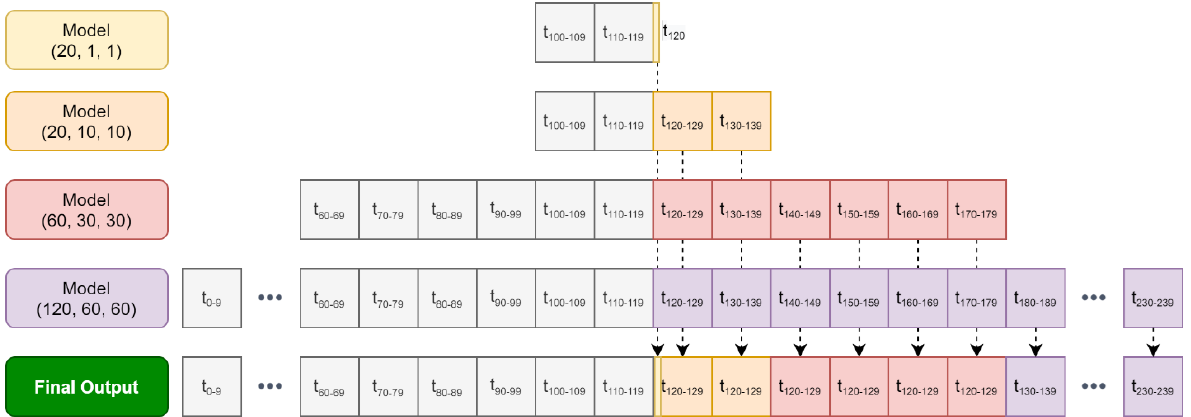
Figure 7. Process of stacking different results coming from different neural networks. Grey squares represent inputs, while yellow, orange, red, and purple squares denote outputs for each model denoted by corresponding triplet (I, O, F). Last line outlines final output, concatenation of all different